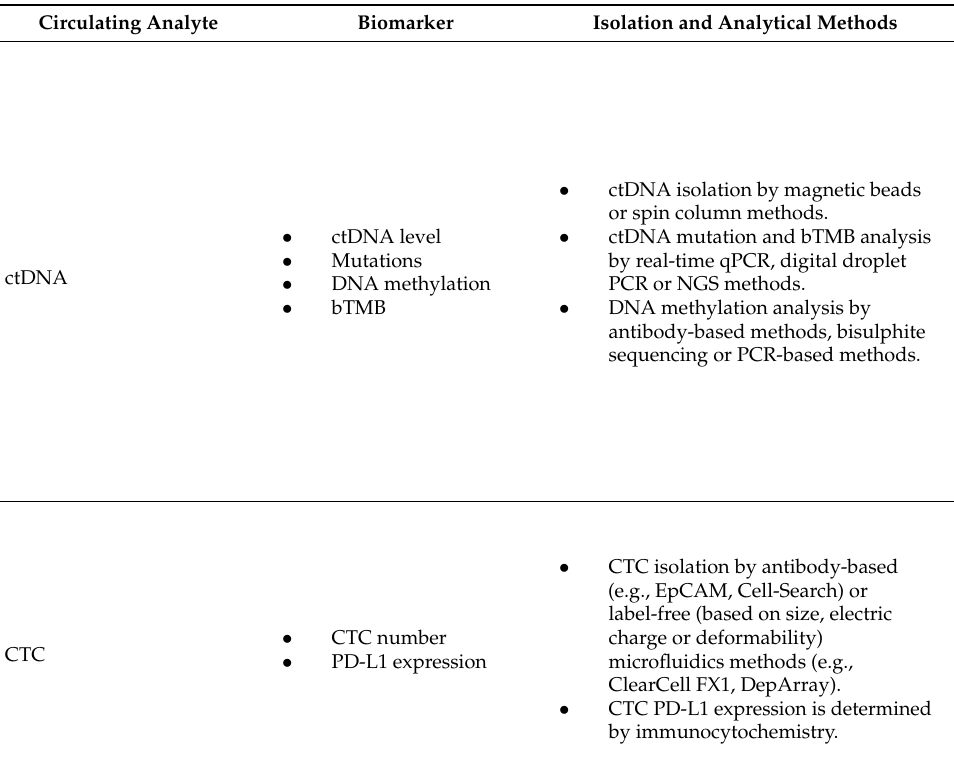
Table 2. Advantages and limitations of circulating